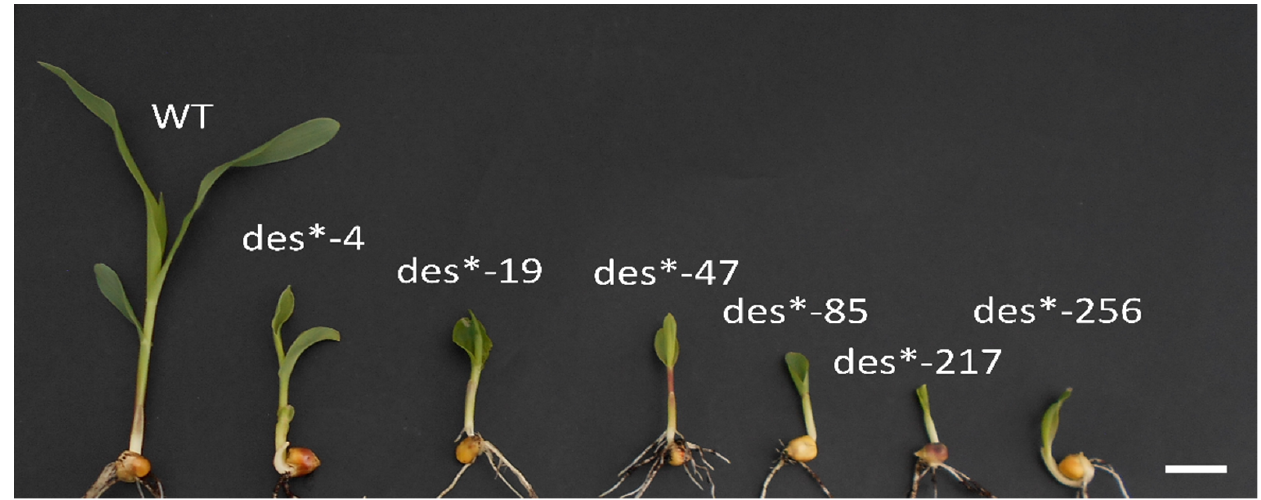
Figure 1. Phenotype of des mutant seedlings: pictures of wild type (WT) and mutant seedlings obtained from the EMS mutagenized population at 10 days after sowing (DAS): WT, des*-4 , des*- 19/stocky1 , des*-47 , des*-85 , des*-217 , des*-256 . Scale bar: 1 cm. The mutants show a dwarf phenotype, and are delayed in the first phases of seedling development. Table 1. Results for the segregation of mutant phenotypes. m: mutant, Sig: significance (NS = not significant).